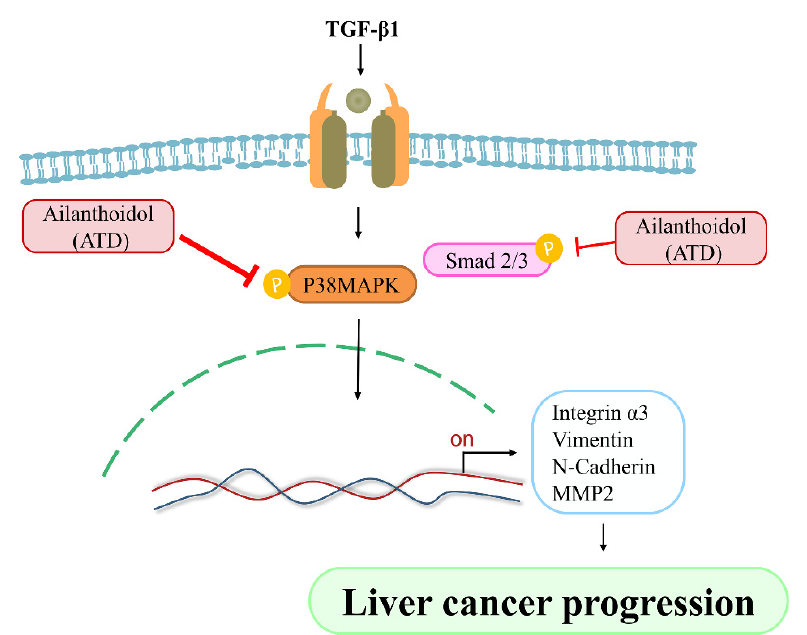
Figure 9. Effect of anti-tumor potential of Ailanthoidol (ATD), ATD blocks TGF- β 1 activated two signaling axes: P38MARK pathway and Smad 2/3 pathway, resulting in down-regulation of liver cancer progression associated proteins.